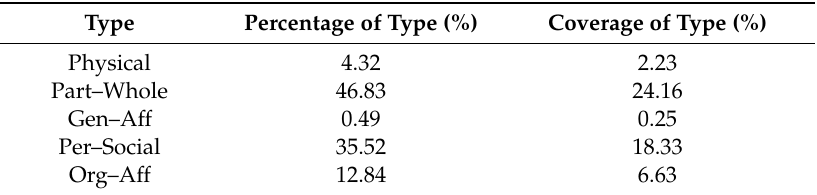
Table 12. Relation type statistics for the initial corpus.